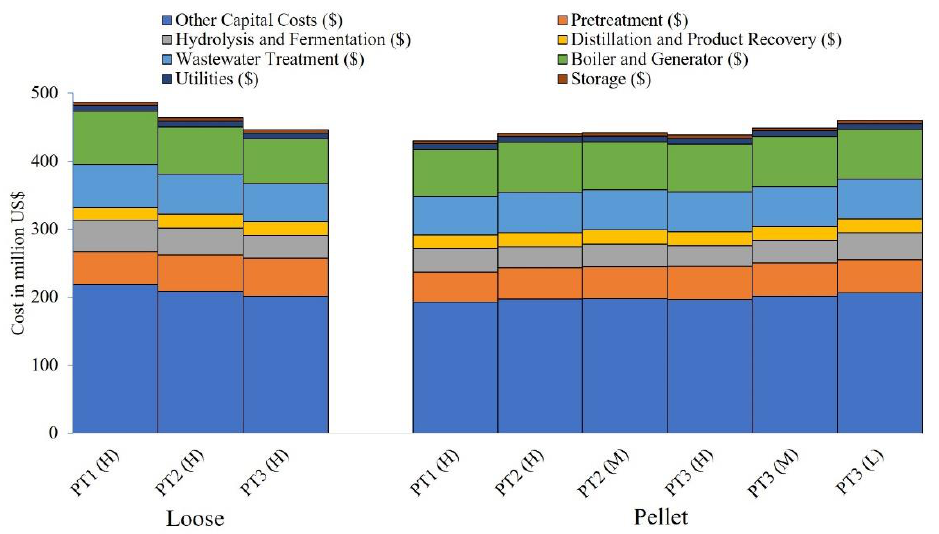
Figure 2. Capital cost breakdown into each area for loose and pelleted biomass under different pretreatment (PT1: 45 °C, 9 h, 12% ammonia; PT2: 50 °C, 14 h, 14% ammonia; PT3: 55 °C, 19 h, 16% ammonia) and enzyme loadings conditions (low, medium, and high enzyme loadings).